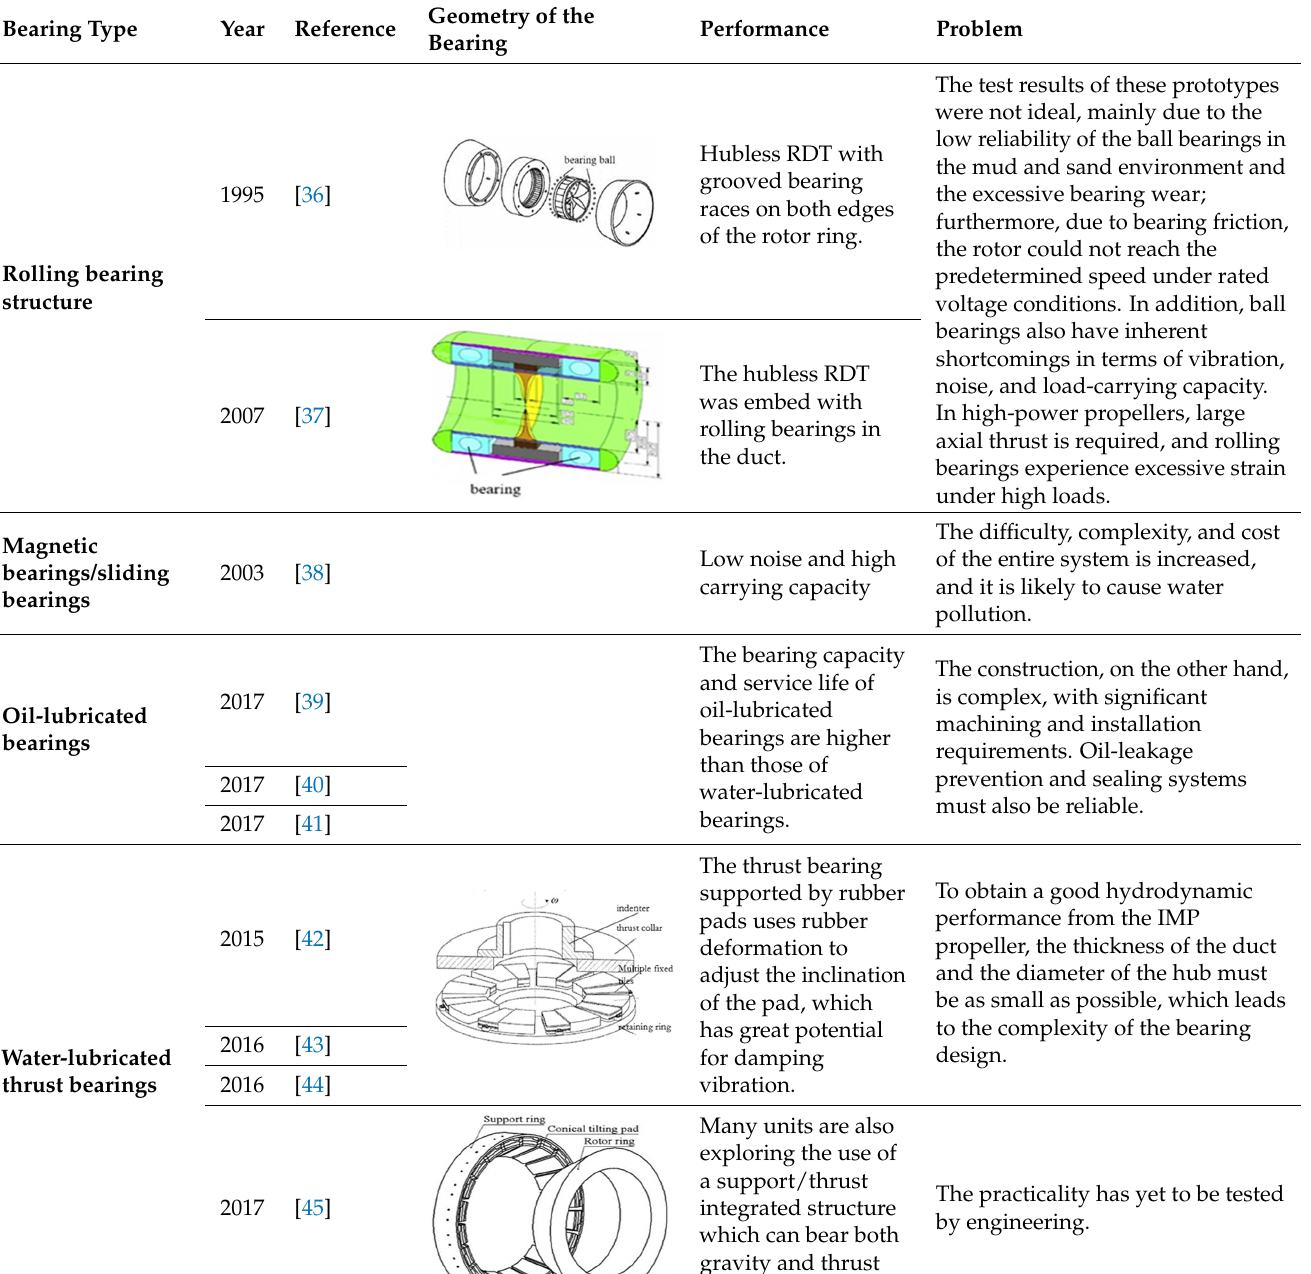
Table 2. Types of bearings applicable to IMP.